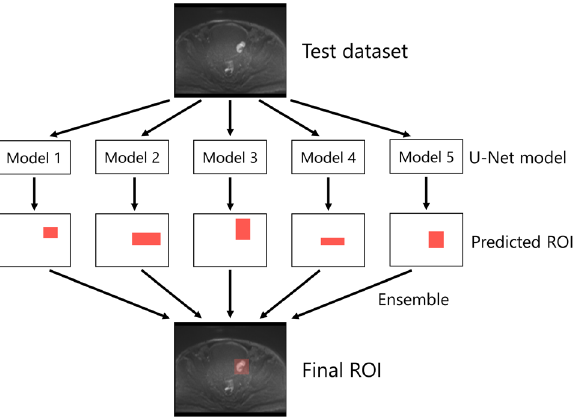
Figure 3. The ensemble model to predict the area of bladder cancer in the test dataset. ROI region of interest.